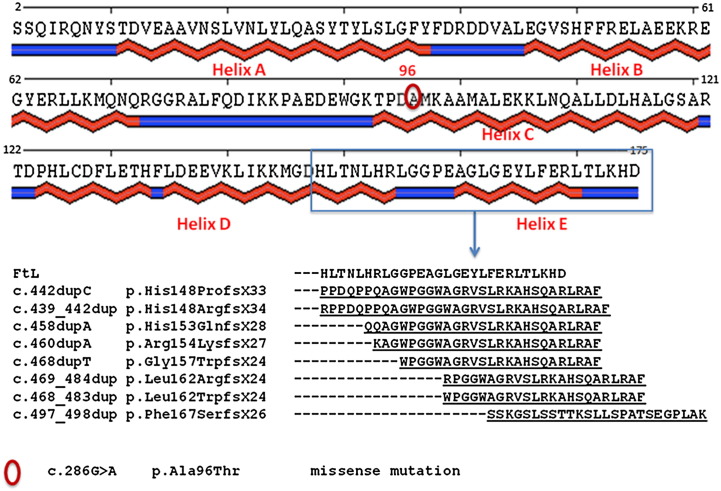
Schematic representation of L ferritin secondary structure and sequence alignment of FtL and NF variants. Human L ferritin sequence is matched with a schematic diagram of protein secondary structure elements that include five α-helices segments (red in upper figure), conventionally named with letters from A to E, connected by four loop elements and of two additional loops at the N and C termini (shown in blue). The red circle marks the position of residue 96, mutated in the unique missense variant (p.Ala96Thr). The blue rectangle highlight the sequence interval, from residue 148 to 175, involved in the so far detected frameshift variants. Frameshift mutations observed in patients are responsible for aminoacidic changes at the C-terminus starting from different sequence position depending on the duplication starting point. In panel B the alignment of the frameshift altered regions compared with the wild type FtL sequence is shown. Dashes correspond to unchanged position while modified residues are underlined.